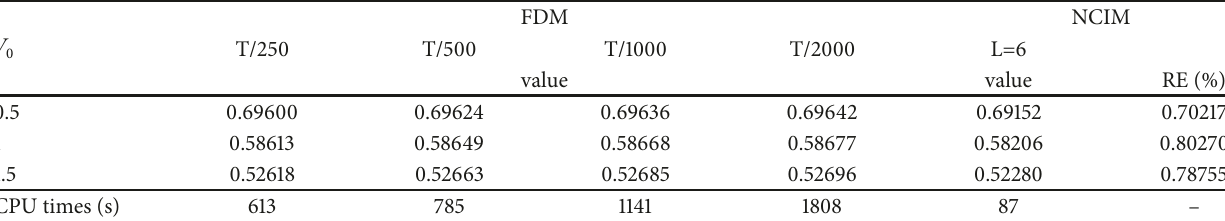
Table 6: Comparison results (option values, relative errors and CPU time).